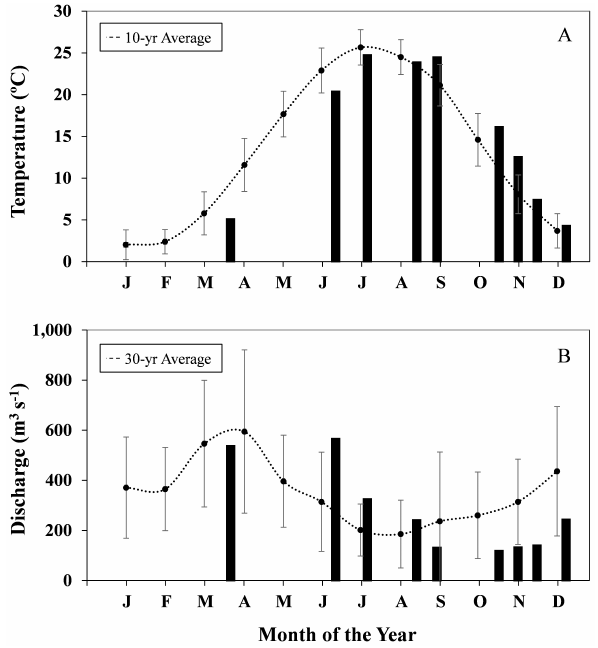
Figure 4. (a) Surface water temperatures and (b) Delaware River discharge rates recorded in the Delaware Estuary during each sam- pling month. Error bars represent standard deviations of the 10-year (2004–2014) and 30-year (1980–2014) monthly averages for sur- face water temperatures and Delaware River discharge rates, respec- tively.